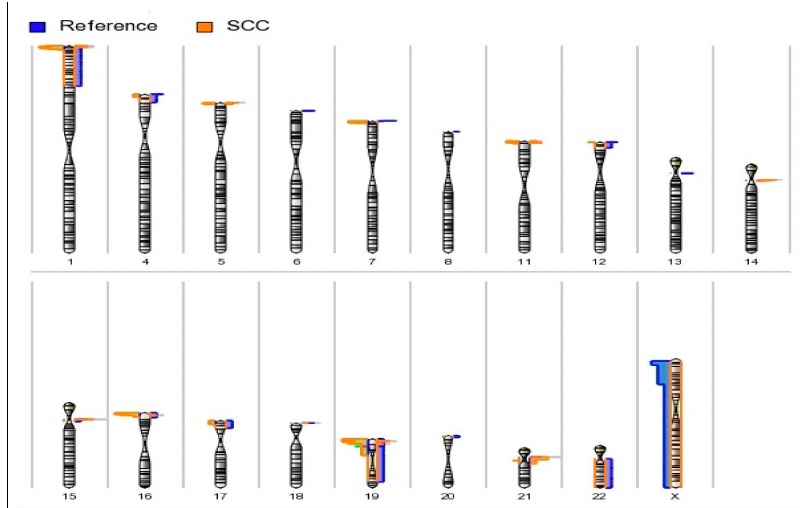
Figure 1. Karyogram view of detected amplified and deleted regions across autosomes.